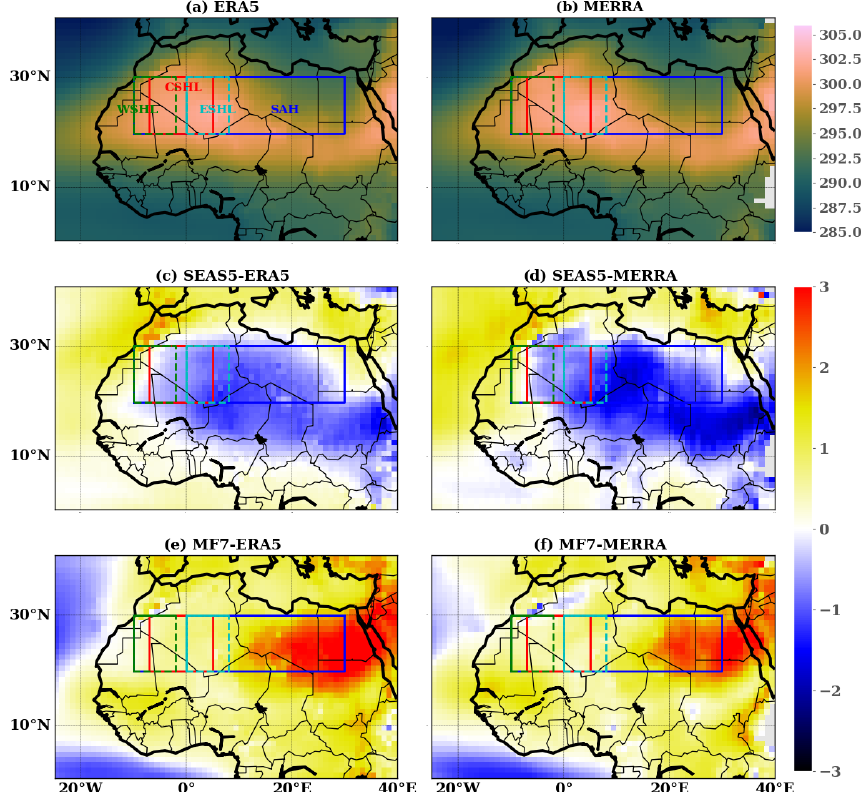
Figure 2. Climatology of the SHL during the JJAS period over 1993–2016 in the reanalysis data using T850, (a) ERA5 and (b) MERRA, and the anomalies of the climatologies of the SHL between (c) SEAS5 and ERA5, (e) SEAS5 and MERRA, (d) MF7 and ERA5, and (f) MF7 and MERRA. The rectangles indicate the boxes chosen for the computation of the average T850 and their corresponding name. WSHL: western SHL; CSHL: central SHL; ESHL: eastern SHL; SAH: the Saharan region. The color bars indicate T850 (a, b) and the anomalies of T850 (c–f) in kelvins. The computation was made using the ensemble mean